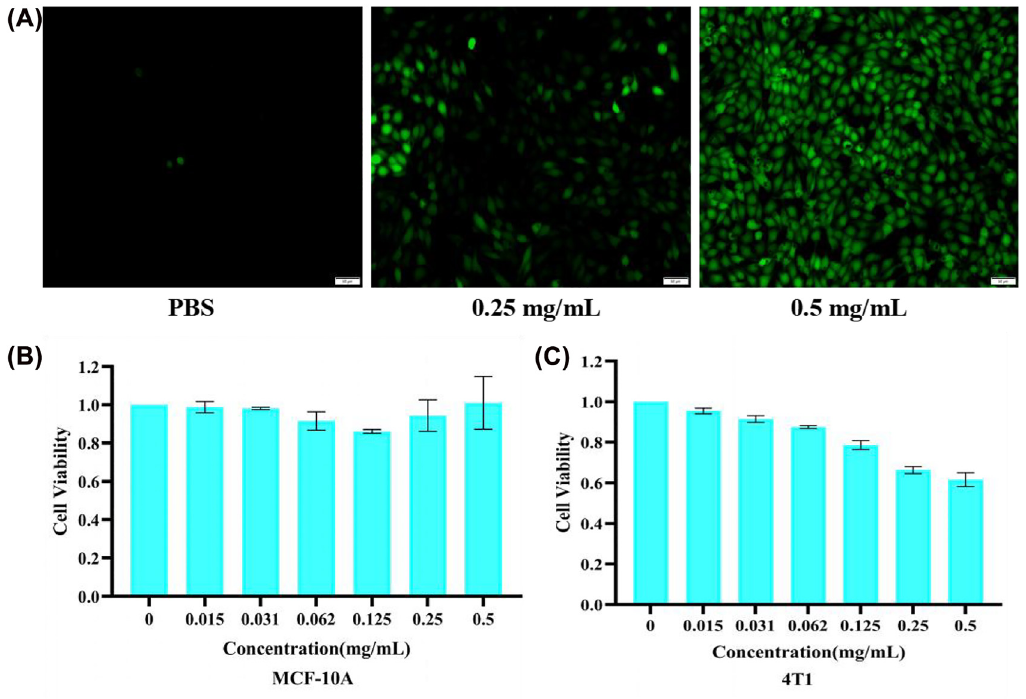
C @PEG. (A) Fluorescence microscope images of 4T1 cells incubated with ROS 3 2 C @PEG. Scale bar is 50 μ m. Relative viabilities of (B) MCF-10A and (C) 4T1 3 2